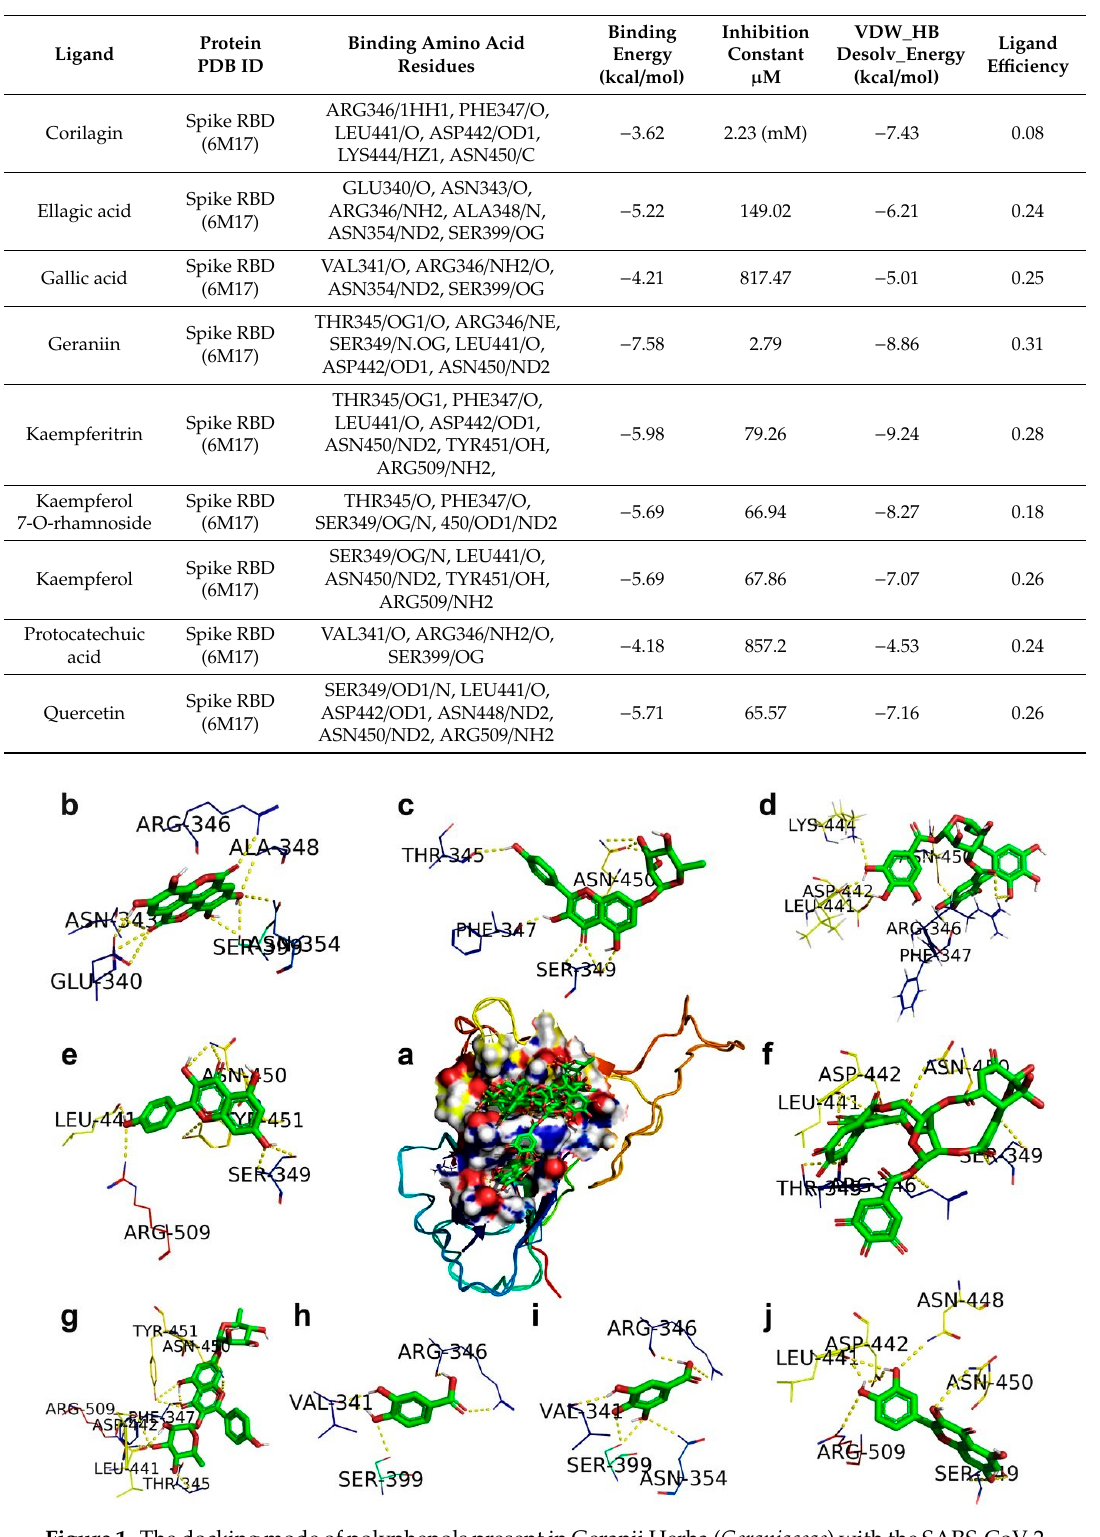
Figure 1. The docking mode of polyphenols present in Geranii Herba ( Geraniaceae ) with the SARS-CoV-2 spike receptor-binding domain (RBD). ( a ) The 9 polyphenols are retained in the cavity of the surface region of the RBD. ( b ) Ellagic acid. ( c ) Kaempferol 7- O -rhamnoside. ( d ) Corilagin. ( e ) Kaempferol. ( f ) Geraniin. ( g ) Kaempferitrin. ( h ) Protocatechuic acid. ( i ) Gallic acid. ( j ) Quercetin. Ellagic acid interacted through H-bonding with the residues GLU340, ASN343, ARG346, ALA348, ASN354, and SER399 with an energy of − 5.22 kcal/mol and the van der Waals interactions with an energy of − 6.21 kcal/mol of the SARS-CoV-2-S. Protocatechuic acid interacted through H- bonding with the residues VAL341, ARG346, and SER399 with an energy of − 4.18 kcal/mol and the van der Waals interactions with an energy of − 4.53 kcal/mol of the SARS-CoV-2-S. Kaempferol 7- O - rhamnoside interacted through H-bonding with THR345, PHE347, SER349, and ASN450 with an energy of − 5.69 kcal/mol and the van der Waals interactions with an energy of − 8.27kcal/mol of the SARS-CoV-2-S. Corilagin interacted through H-bonding with the residues ARG346, PHE347, LEU441, ASP442, LYS444, and ASN450 with an energy of − 3.62 kcal/mol and the van der Waals interactions with an energy of − 7.43 kcal/mol of the SARS-CoV-2-S. As a result, kaempferol 7-O- rhamnoside and corilagin achieved ligand efficiencies of 0.18 and 0.08, respectively. Similar to our study, the RBD–ACE2 interaction showed strong H-bonding at TYR 505, indicating an initial contact point with ACE-2 and THR 500, ASN 501, GLY 502, TYR 449, GLN 493, and GLN 498, suggesting a strong polar interaction [27]. From this analysis, we determined that the polyphenolic compounds interact with the active sites of the SARS-CoV-2 RBD and lead to inhibiting the interaction of the SARS-CoV-2 RBD with ACE2.